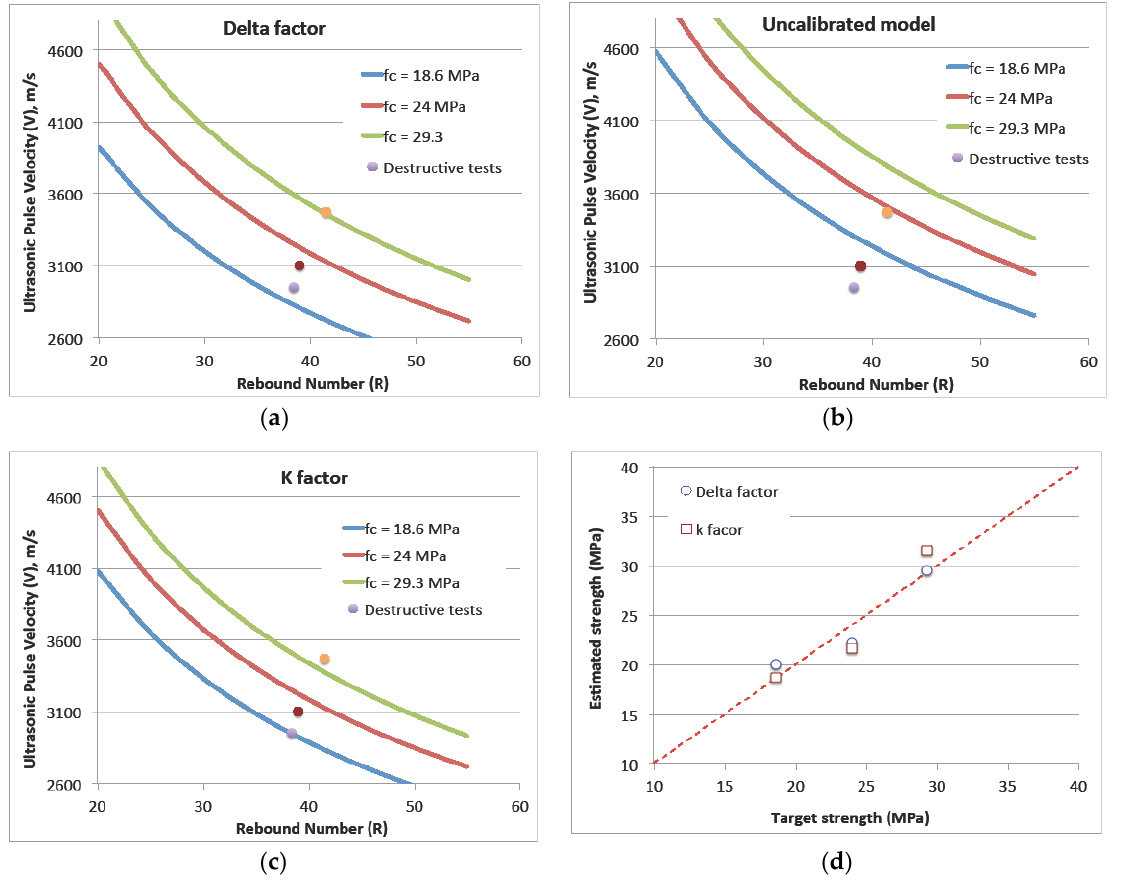
Figure 3. In situ case study of using the calibration methods on the SonReb model ( a ) uncalibrated model, ( b ) calibration by ∆ -method, ( c ) calibration by k -method, ( d ) the error of calibration of the two methods (shifting and multiplication) [7].